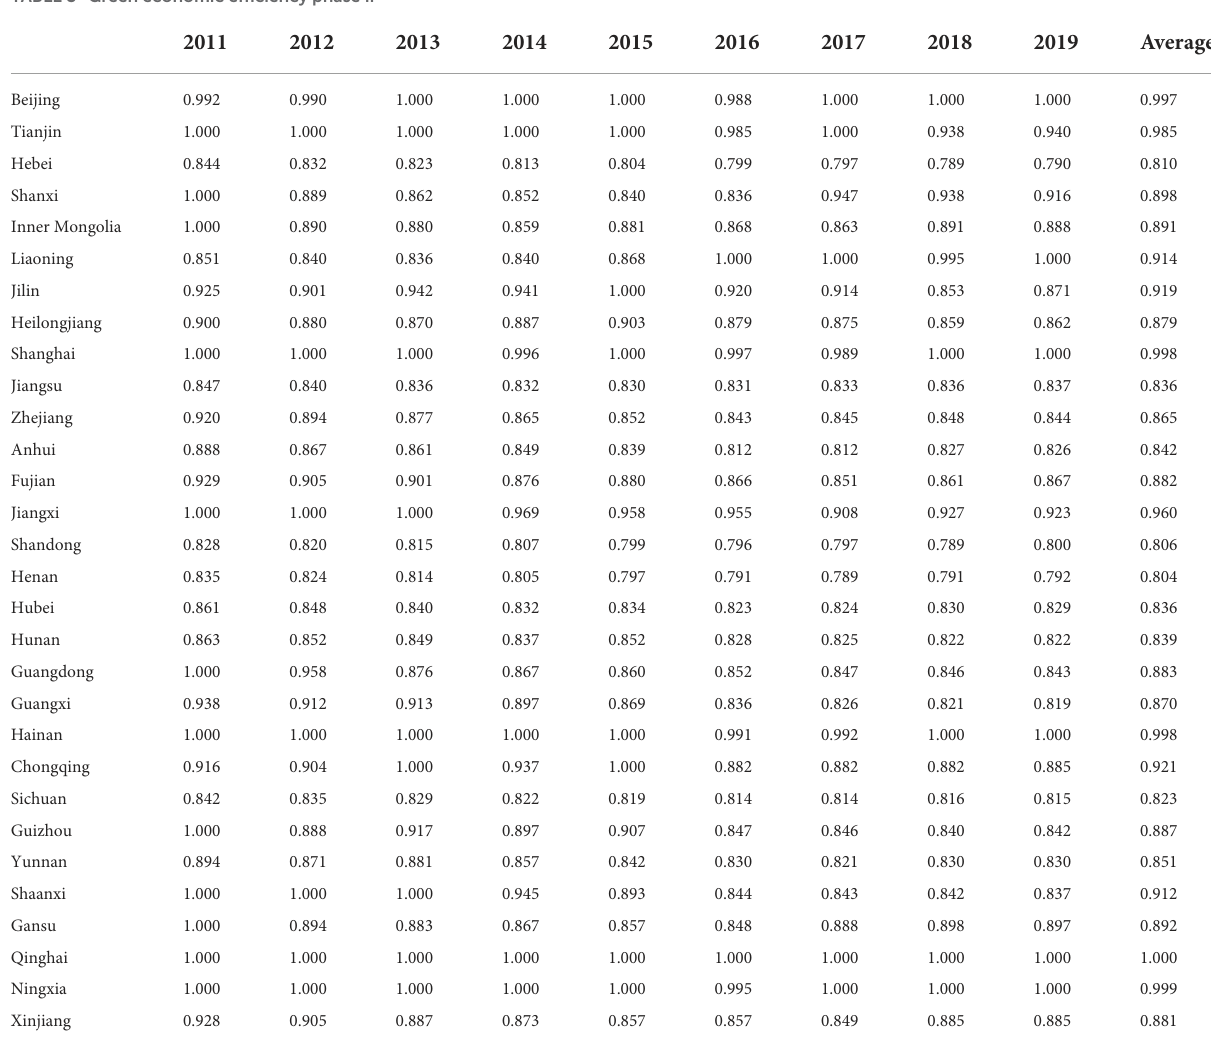
TABLE 3 Green economic efficiency phase